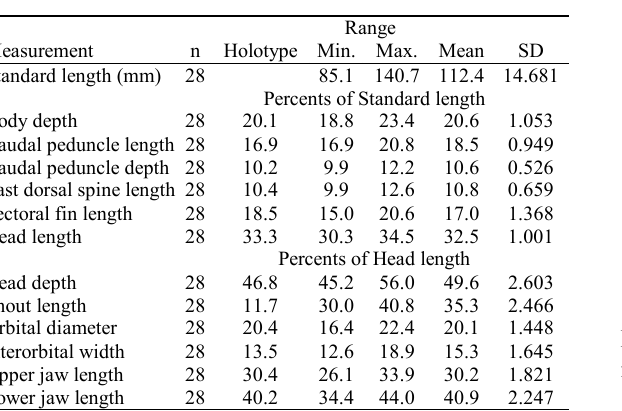
Table 3 . Morphometrics of Crenicichla empheres. SD = stan- dard deviation; n = number of specimens.